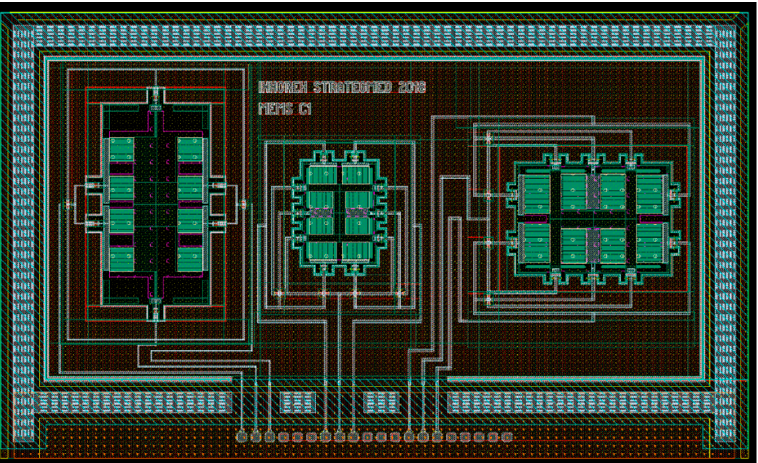
Figure 4. 3-axis MEMS accelerometer layout. ( right ) X-axis accelerometer, ( centre ) Y-axis accelerometer, ( left ) Z-axis accelerometer.